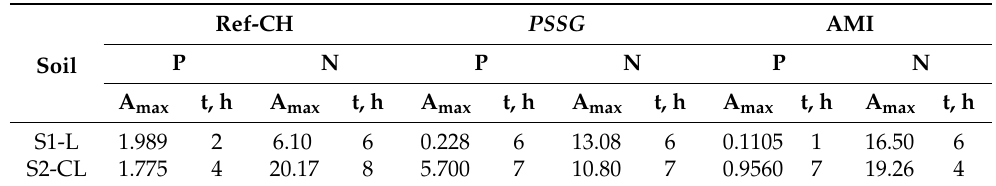
Figure 5. Fractions of ammonium nitrogen adsorbed ( a ) and leached ( b ) of the fertilizers on the mixture of sand and soil S2-CL. Table 5. Maximum adsorption capacity (A max ) in mg/g and equilibrium time, hours, of the two soils for nitrogen and phosphorus nutrients released from tested